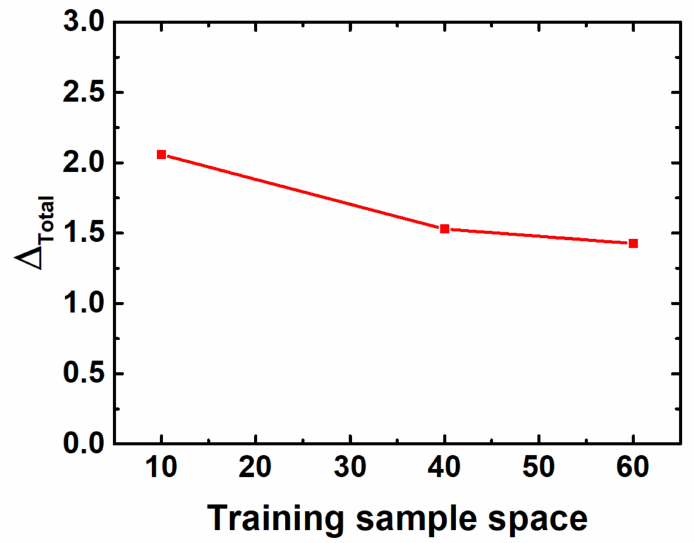
Figure 7. The total relative errors of the predicted results with di ff erent number of training